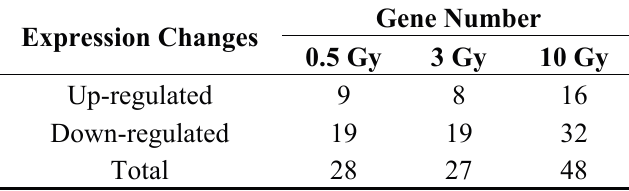
Table 1. Numbers of genes with changed transcription levels in irradiated human peripheral blood